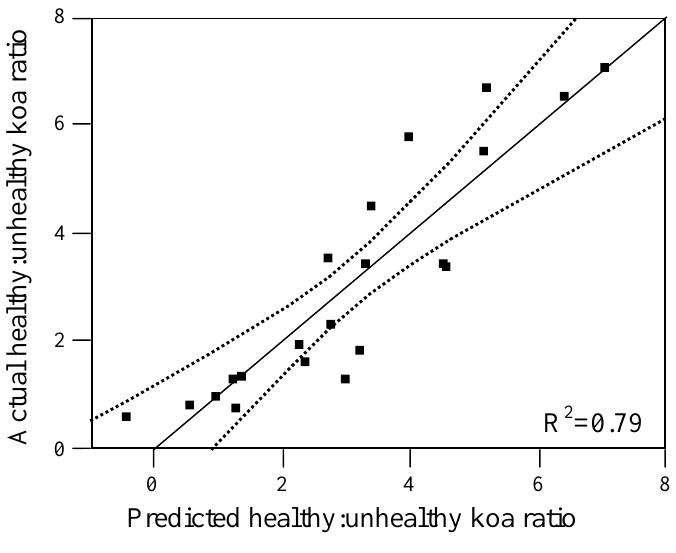
Figure 7. Actual vs. predicted healthy:unhealthy koa ratios using the best model selected from the stepwise regression analysis that included MAT, MAP and PET. Dotted lines represent 95% confidence